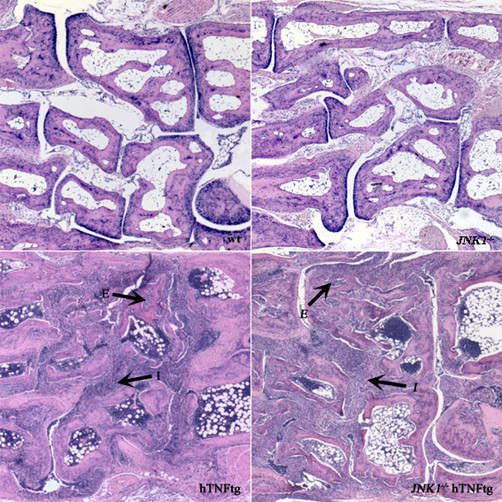
Histological assessment of synovial inflammation and joint destruction. No signs of arthritis are seen in the tarsal joints of wild-type (wt) and JNK1 (c-Jun N-terminal kinase 1) knockout (JNK1-/-) mice, whereas severe inflammation (I) and numerous erosions (E) are observed in human TNF transgenic (hTNFtg) and intercrossed (JNK1-/-hTNFtg) mice. H-&-E-stained sections; magnification 50×.